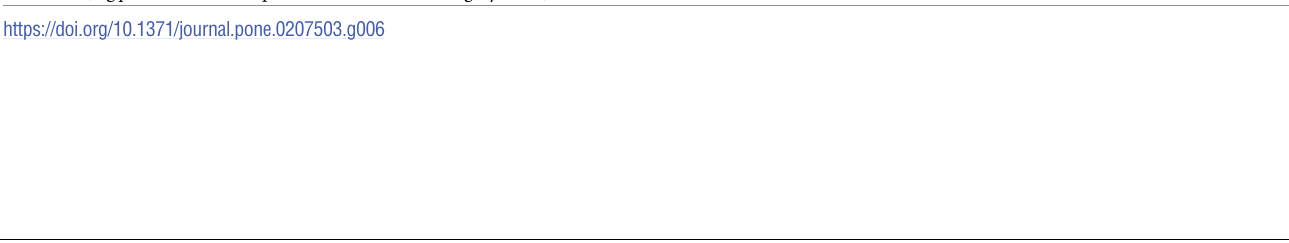
PLOS ONE | https://doi.org/10.1371/journal.pone.0207503 February 11,